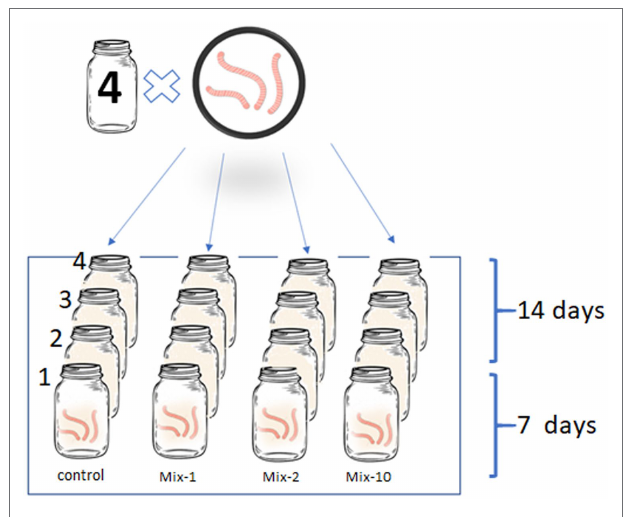
FIGURE 1 | Illustration of the experimental